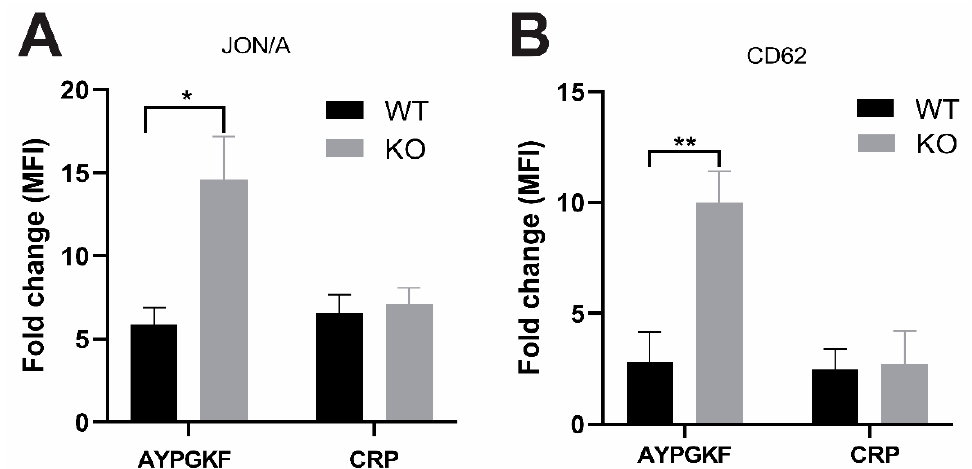
Figure 1. Agonist-induced platelet aggregation and dense granule secretion in the GPCR kinase (GRK)6-deficient platelets. Washed platelets from GRK6 − / − mice and GRK6 +/+ littermates were stimulated with G-protein-coupled receptor (GPCR) agonists 30 nM 2MeSADP, 50 nM U46619, 60 µM AYPGKF, 0.1 unit/mL thrombin and GPVI agonist 2.5 µg/mL collagen-related peptide (CRP) for 3.5 min under stirring conditions. ( A ) Platelet aggregation (top) and ATP secretion (bottom) were measured in a lumi-aggregometer. All tracings shown are representative of at least three different experiments. ( B ) Quantification of extent of aggregation and dense granule secretion from panel A. Data are presented as mean ± SE *, p < 0.05; **, p < 0.01; ***, p < 0.005.